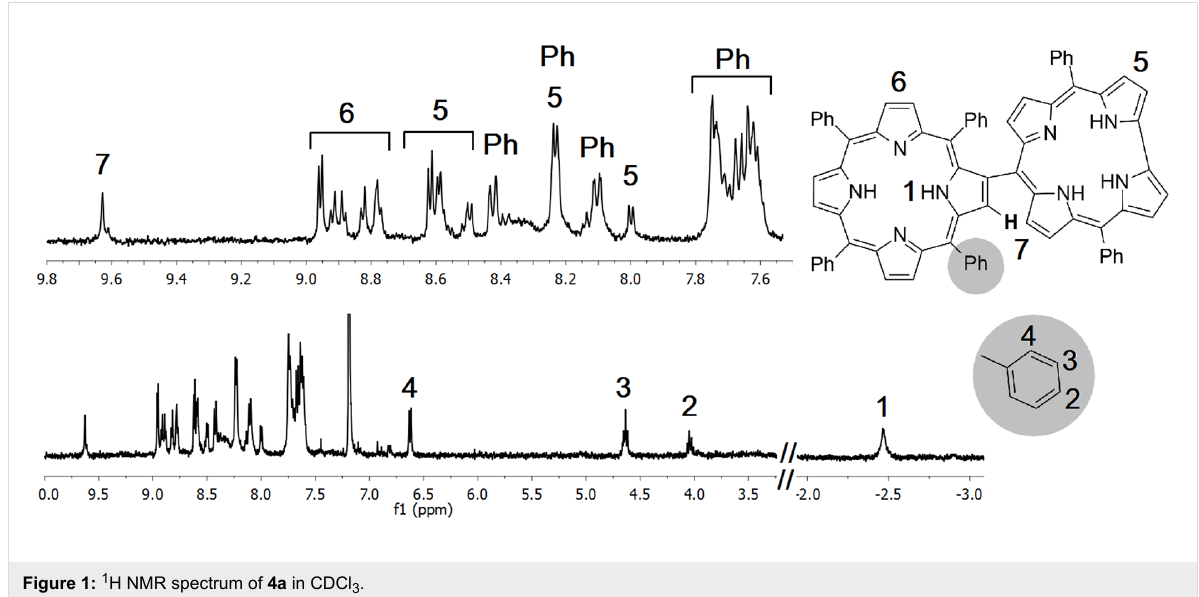
Figure 1: 1 H NMR spectrum of 4a in CDCl 3 .